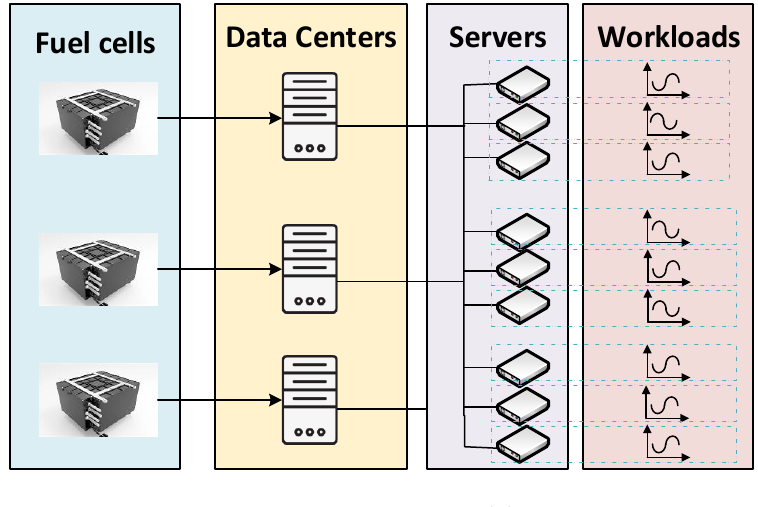
Figure 2. System